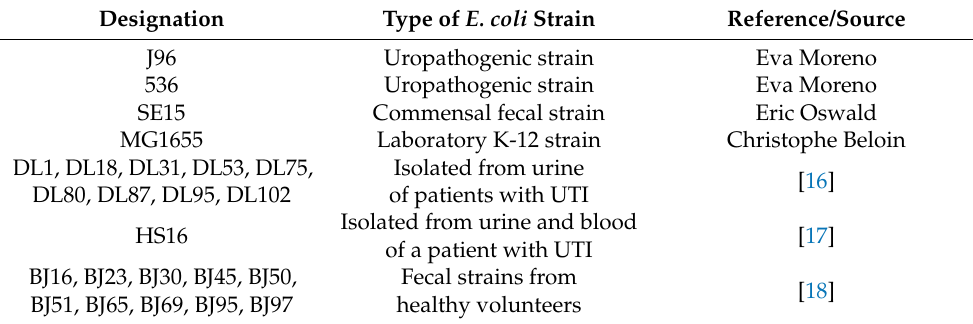
Table 1. Strains used in this